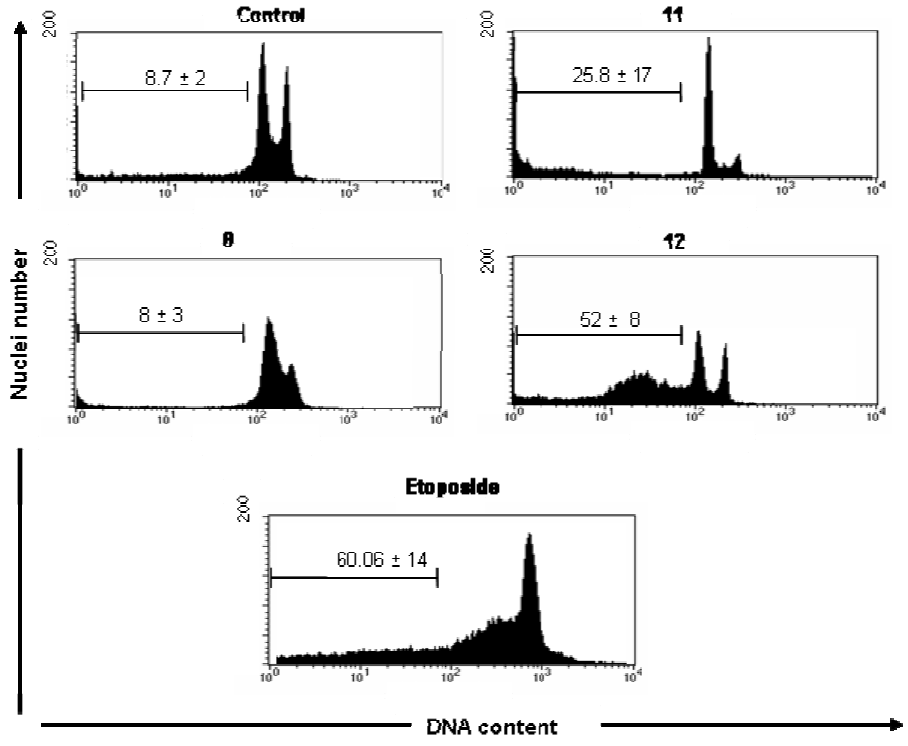
Figure 2. Cell cycle analysis of UACC-62 cells in the absence (control, DMSO 0.5%) and presence of 100 μ M of 8, 11 and 12 compounds. Logarithmic representations of fluorescence intensity obtained by PI-staining to distinguish live from apoptotic cells. Sub- G1 peaks are clearly evident after 11 and 12 treatments. Pro-apoptotic drugs, etoposide and camptothencin were used as positive control. Representative data (mean ± SD) of three experiments performed in triplicate. * Statistically different of untreated cell control (p <